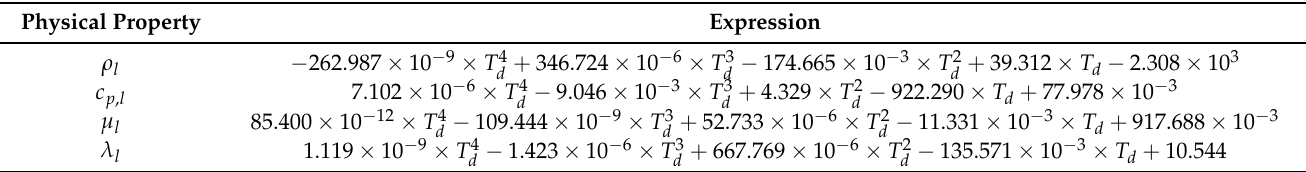
Table A2. Thermophysical properties of liquid water for the temperature range between 273.16K and 335.16K at 1 atm. Physical